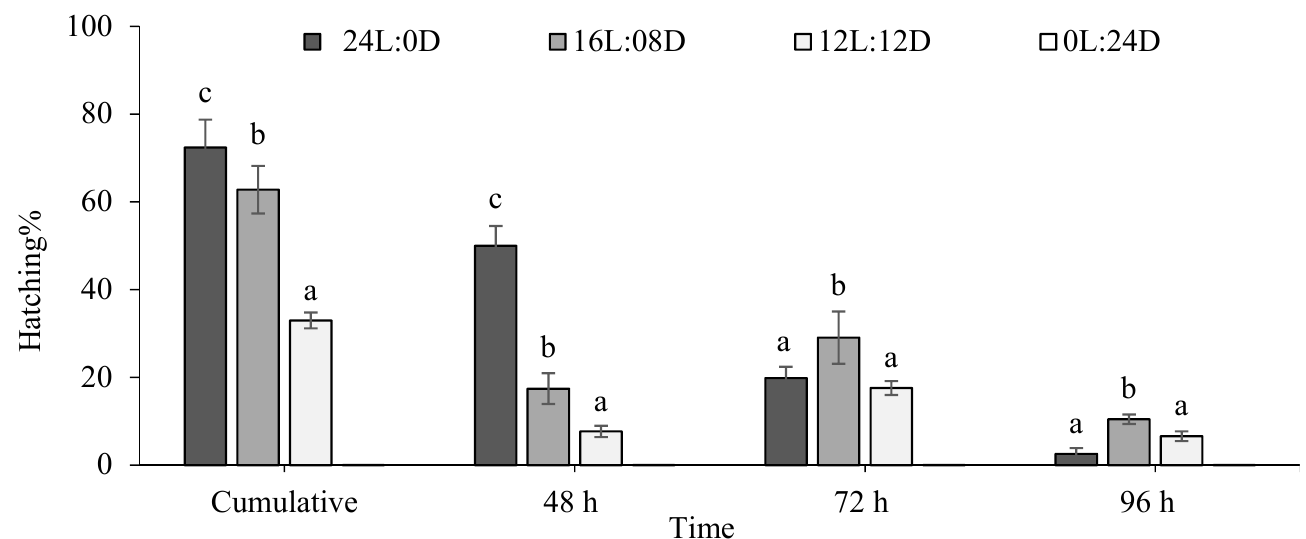
Figure 1. Comparison of hatching characteristics of B. orientalis under different photoperiod regimes (mean ± SD, n = 3). Different superscript letters denote statistically significant differences at each timepoint ( p < 0.05).